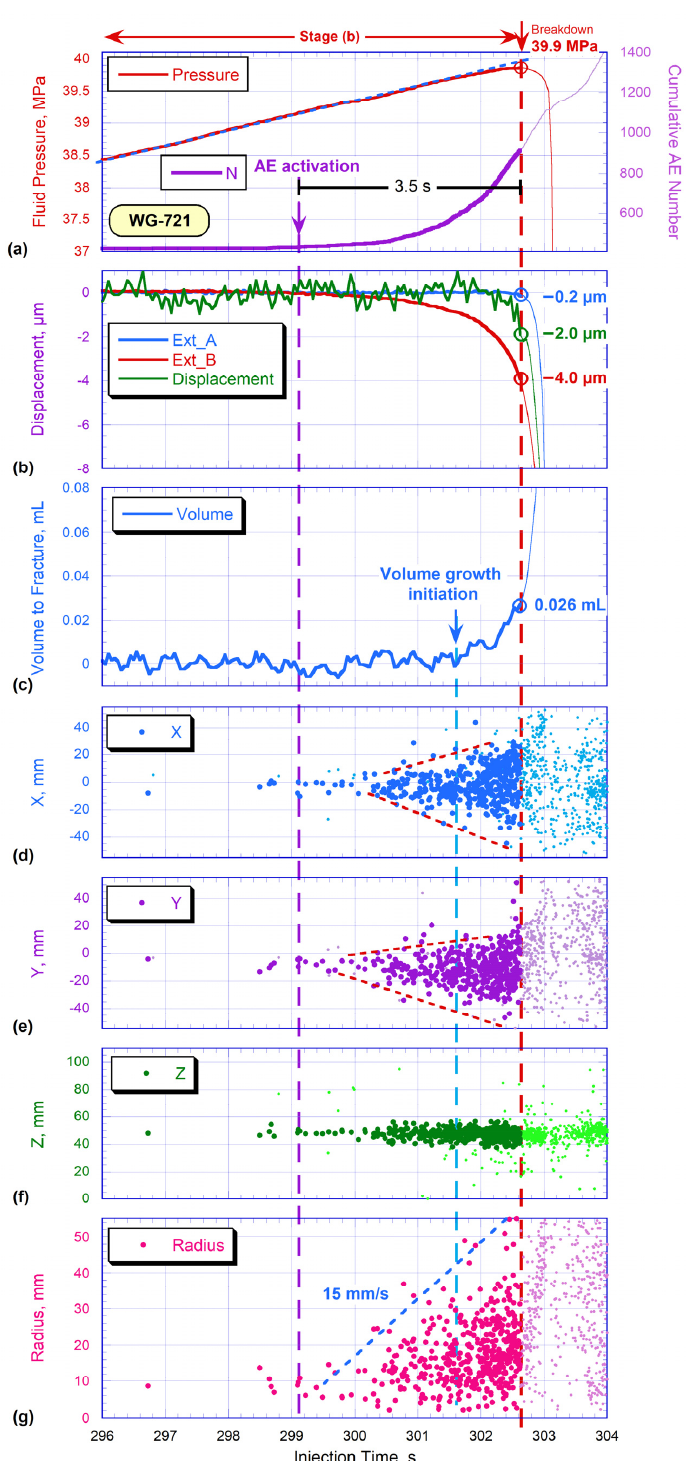
Figure 14. Sample WG-721: ( a ) fluid pressure (red) and the total number of AE signals located (purple); ( b ) axial deformations measured by the left (Ext_B, red) and right (Ext_a, blue) extensometers and a curve demonstrating loading piston position (green); ( c ) the volume of fluid injected into the hydraulic fracture; ( d , e ) horizontal coordinates of the located AE signals in the X and Y directions, respectively; ( f ) vertical coordinates of the located AE signals; ( g ) distribution of the distances between located AE signals and the axis of the sample. All parameters are plotted versus the time of sample